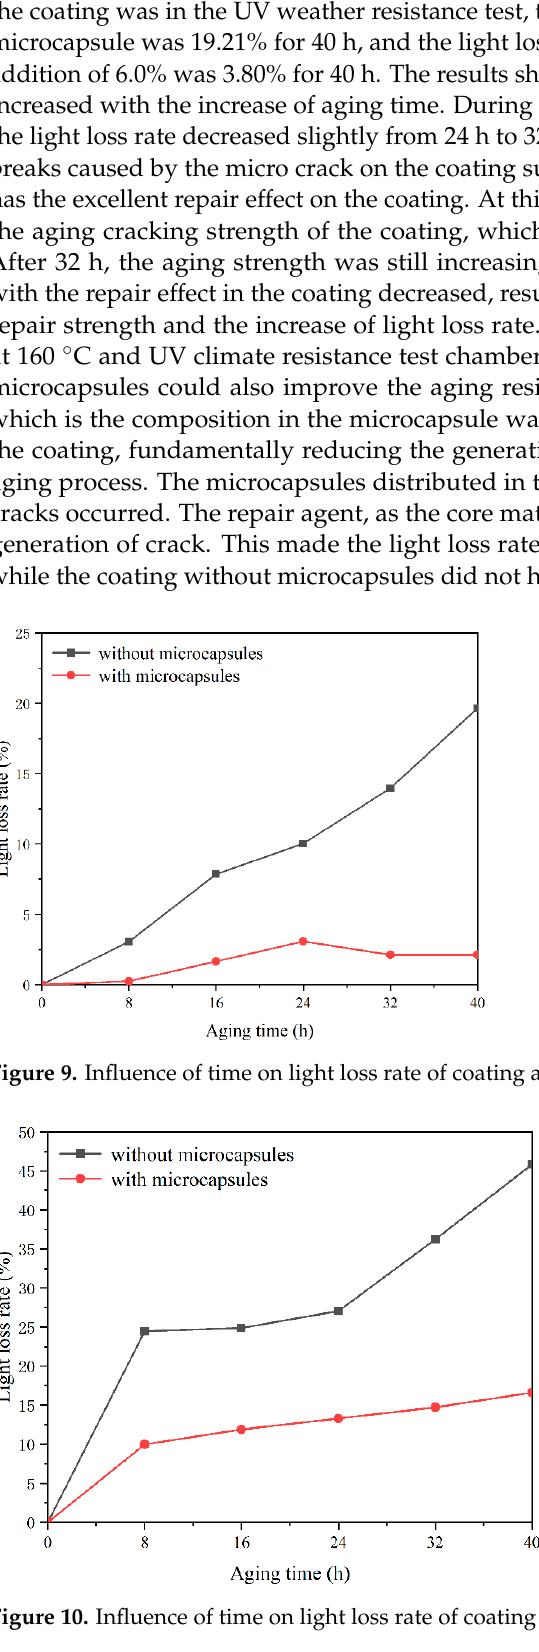
Figure 10. Influence of time on light loss rate of coating at 160 °C in oven.